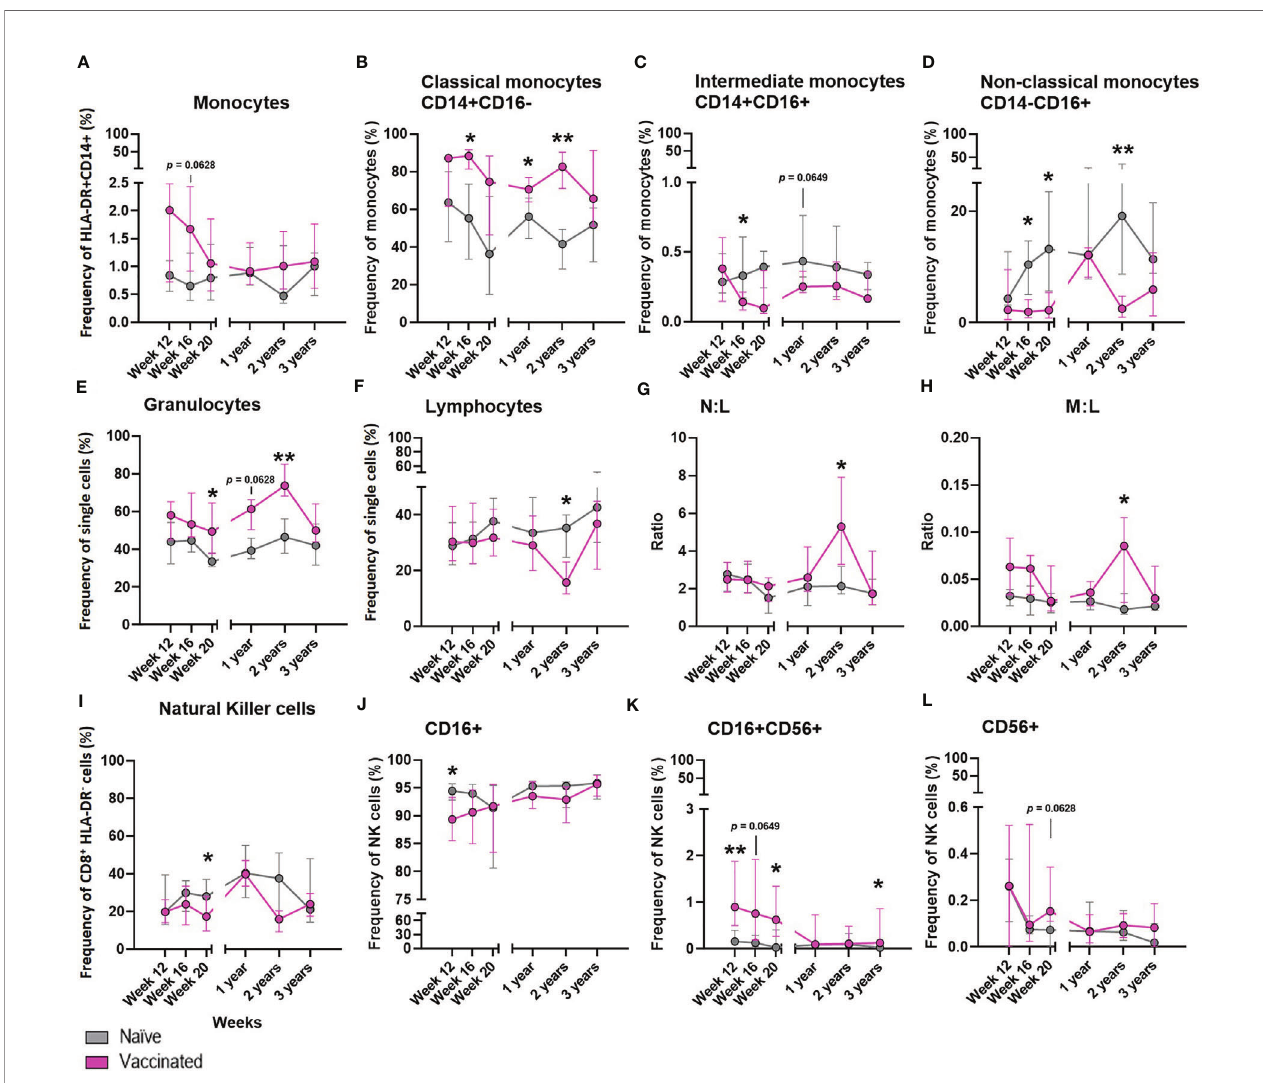
FIGURE 7 | The effect of BCG on the development of whole blood cell populations in neonatal macaques. Plots show the median frequency of (A) total monocytes, (B) classical monocytes, (C) intermediate monocytes, (D) non-classical monocytes, (E) granulocytes, (F) Total lymphocytes, (G) neutrophil: lymphocyte ratio (N:L) (H) monocyte: lymphocyte ratio (M:L) (I) total natural killer cells (J) CD16+ NK cells (K) CD16+CD56+ NK cells and (L) CD56+ NK cells from infancy (12 weeks of age) through to three years in macaques vaccinated within a week of birth (pink) and unvaccinated age-matched controls (grey). Plots show the group median +/- the inter-quartile range. Signi fi cant differences measured by Mann-Whitney U-test between the groups at each time point are indicated in black. *p ≤ 0.05, **p <